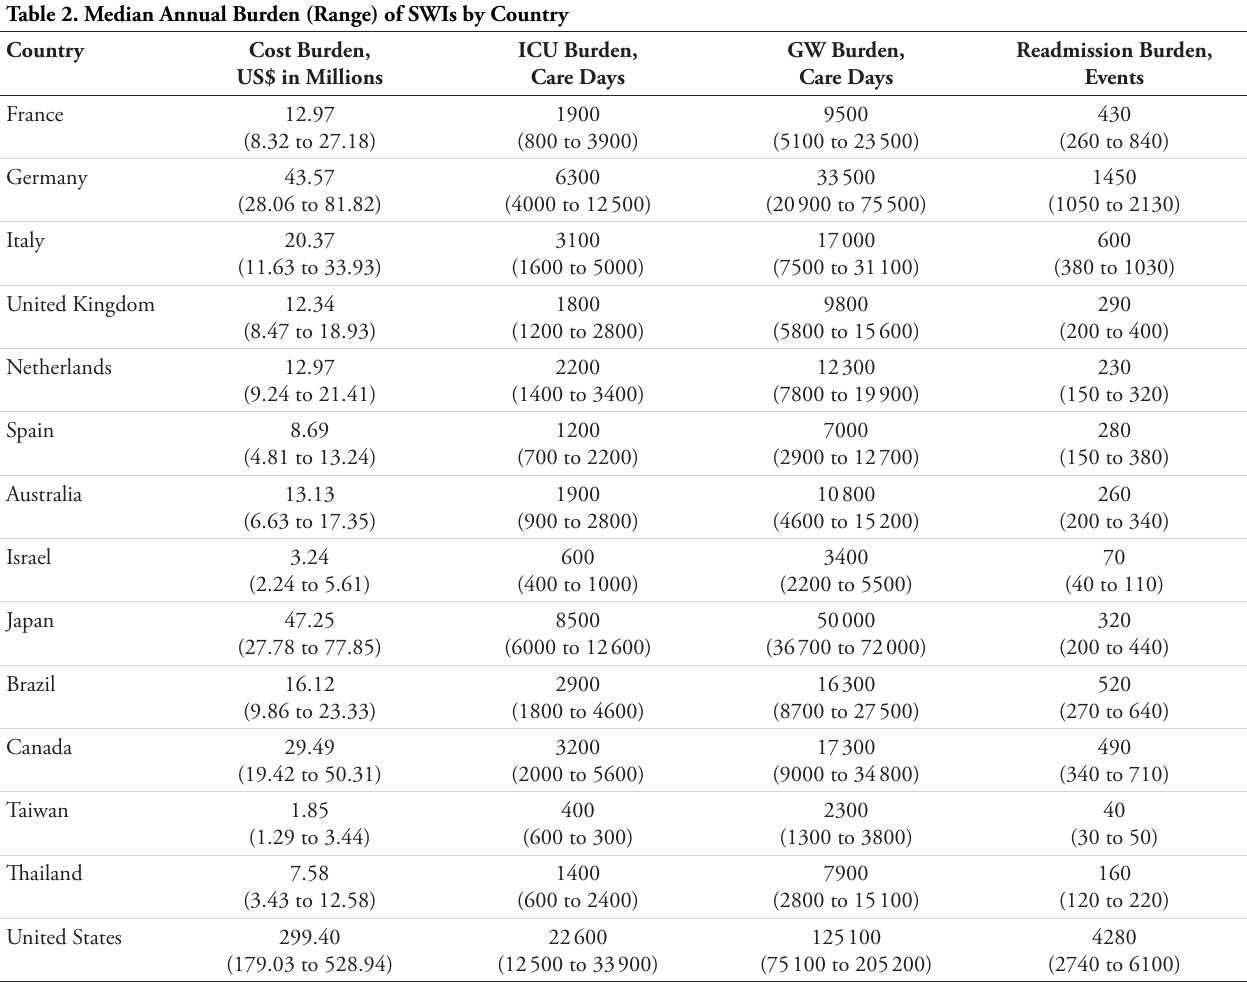
Table 2. Median Annual Burden (Range) of SWIs by Country